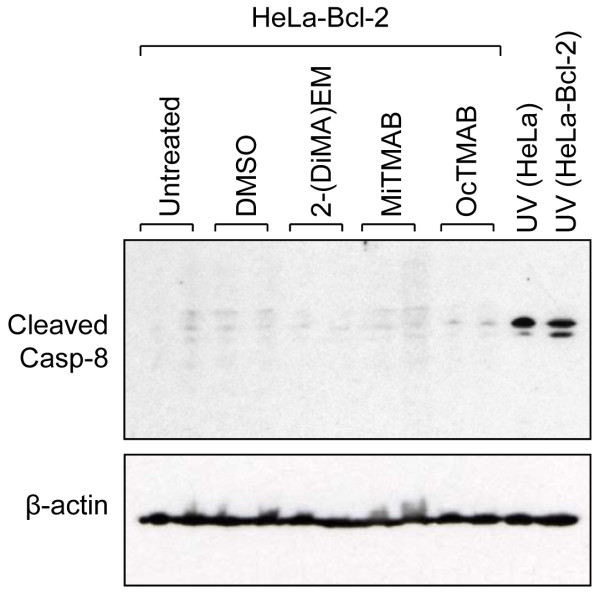
Caspase-8 activation in MiTMAB treated cells occurs downstream of caspase-9/3 activation. G2/M synchronized HeLa-Bcl-2 cells were treated with MiTMABs and controls as described in the legend to Figure 5. Following an 8 h exposure to MiTMABs, lysates (prepared in duplicate) were immunoblotted for caspase-8. In contrast to HeLa cells (Figure 3), cleaved caspase-8 was not observed in HeLa-Bcl-2 cells treated with MiTMABs. Lysates prepared from UV treated HeLa and HeLa-Bcl-2 cells were used as a positive control. β-actin served as a loading control.